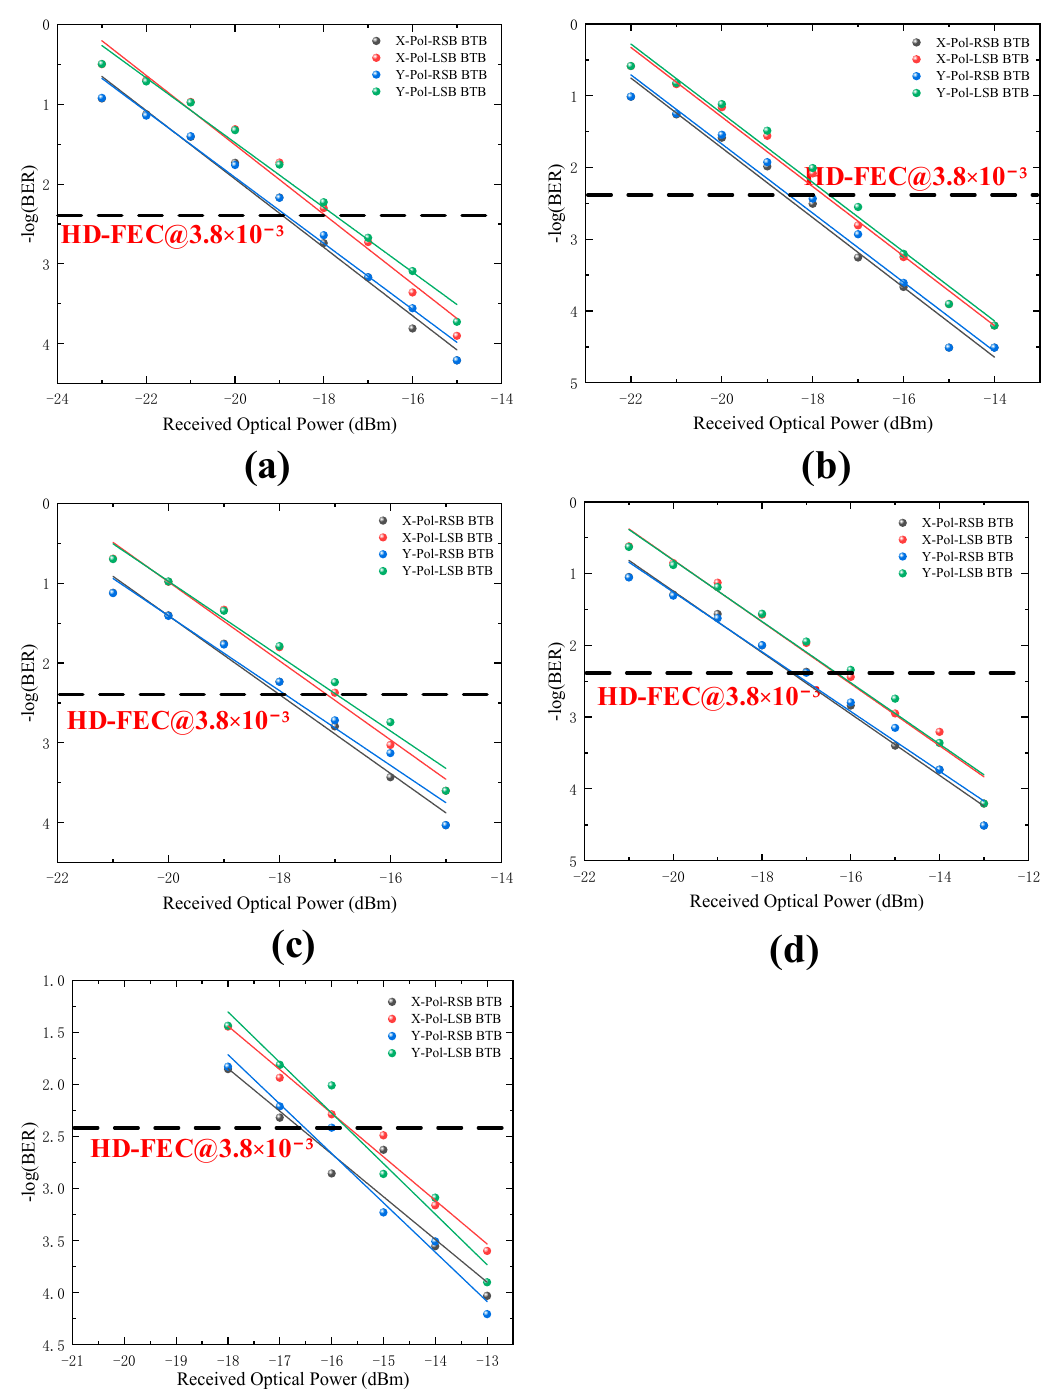
Figure 4. BER versus the received optical power for different baud rates at BTB transmission scenario. ( a ) 8-Gbaud, ( b ) 10-Gbaud, ( c ) 12-Gbaud, ( d ) 14-Gbaud, ( e ) 16-Gbaud. Figure 5a–e show PDM Twin-SSB signal BER performance at 2-km SSMF transmission scenarios with 8-Gbaud, 10-Gbaud, 12-Gbaud, 14-Gbaud, and 16-Gbaud rate cases. When baud rate is lower than 14-Gbaud, the BER can reach below the HD-FEC threshold of 3.8 × 10 − 3 . In Figure 5e, it can be found that the BER cannot reach below the HD-FEC threshold of 3.8 × 10 − 3 after 2-km SSMF channel transmission. The BER performance